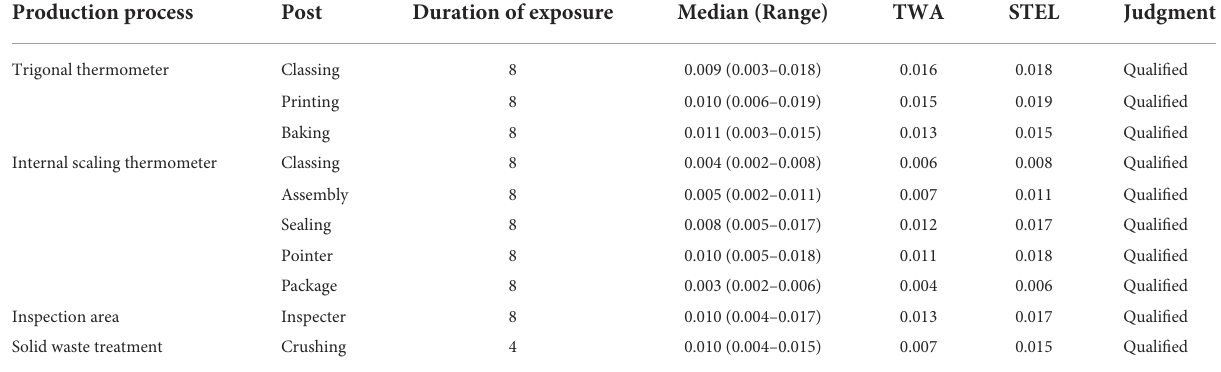
TABLE 2 Results of mercury concentration tests in 2020 (mg/m 3